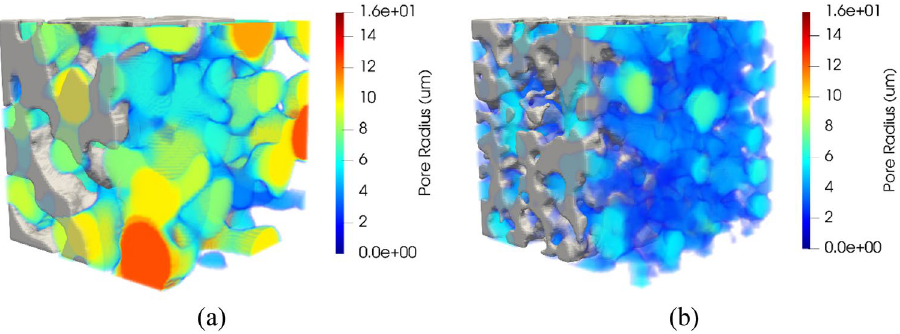
Figure 16. Rendering of selected samples showing the local pore sizes computed by simulated porosimetry method for porous media with porosity of 0.5 and sigma of 2.0 ( a ) and 1.0 ( b